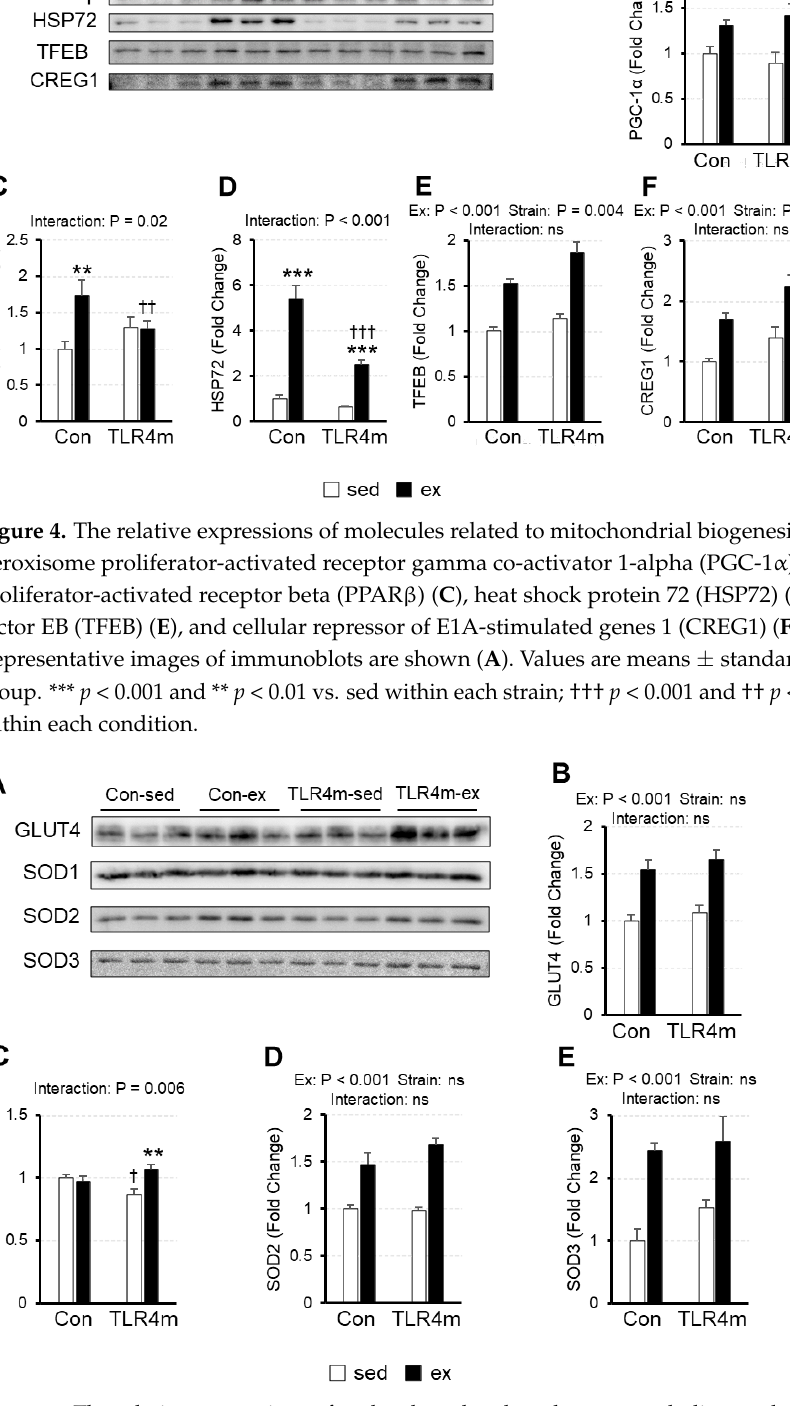
Figure 5. The relative expressions of molecules related to glucose metabolism and oxidative capacity in the plantaris. Glucose transporter 4 (GLUT4) ( B ), superoxide dismutase 1 (SOD1) ( C ), SOD2 ( D ), and SOD3 ( E ) were measured. Representative images of immunoblots are shown ( A ). Values are means ± standard error; n = 6 per group. ** p < 0.01 vs. sed within each strain; † p < 0.05 vs. controls within each condition.